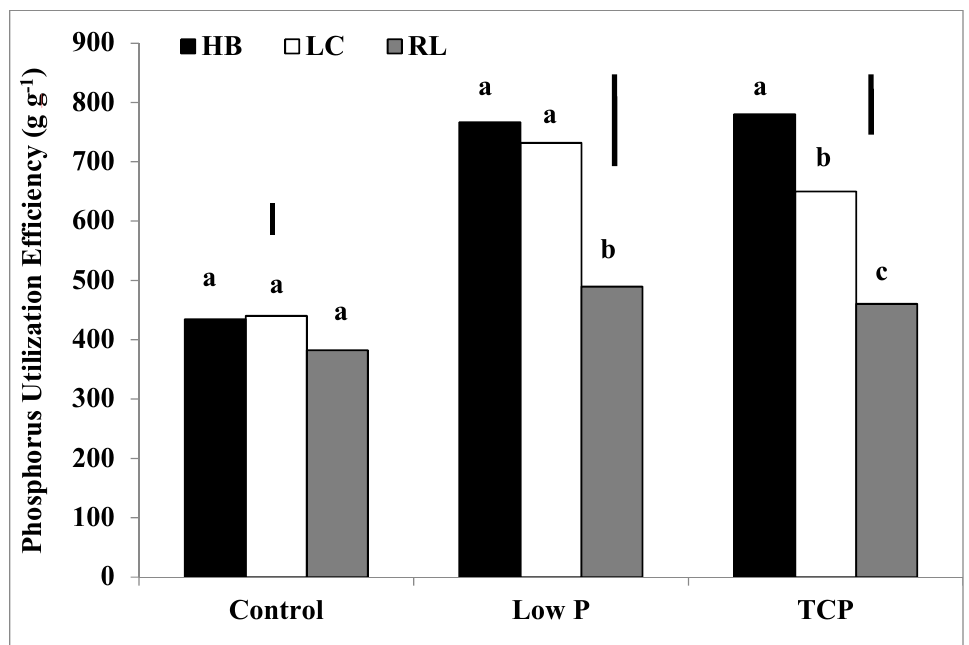
Figure 3. Phosphorus utilization efficiency of 28-days old potato seedlings grown in modified Hoagland solution with different P bioavailabilities. Histograms with different letters in the same treatment are different at p < 0.05. Control: 10 mg L − 1 P as water soluble P, NaH 2 PO 4 ; Low P: 1 mg L − 1 P as water soluble P, NaH 2 PO 4 ; and 286 mg L − 1 TCP, tri-calcium phosphate, Ca 3 (PO 4 ) 2 as sparsely soluble P with 2,286 mg L − 1 laboratory grade Ca 3 (PO 4 ) 2 . HB: ‘Harley Blackwell’; LC: ‘La Chipper’; RL: ‘Red LaSoda’. The bars are the values of LSD 0.05,2 for the plant biomass of the control, low P and TCP, respectively.